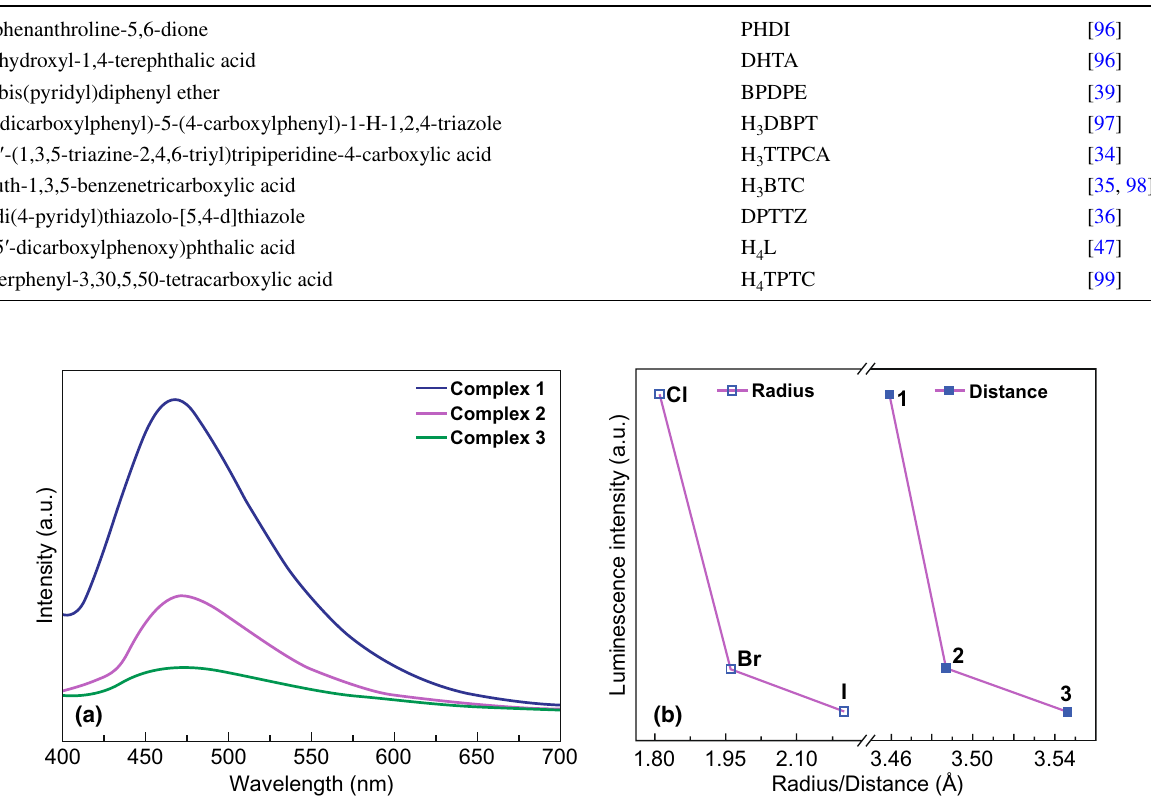
Fig. 6 a Luminescence spectra of the three Pb-MOFs. b Relationship among luminescence intensity, halogen atom radius, and distance between ligands in the three Pb-MOFs. Reprinted with permission from Ref. [34]. Copyright 2019, American Chemical